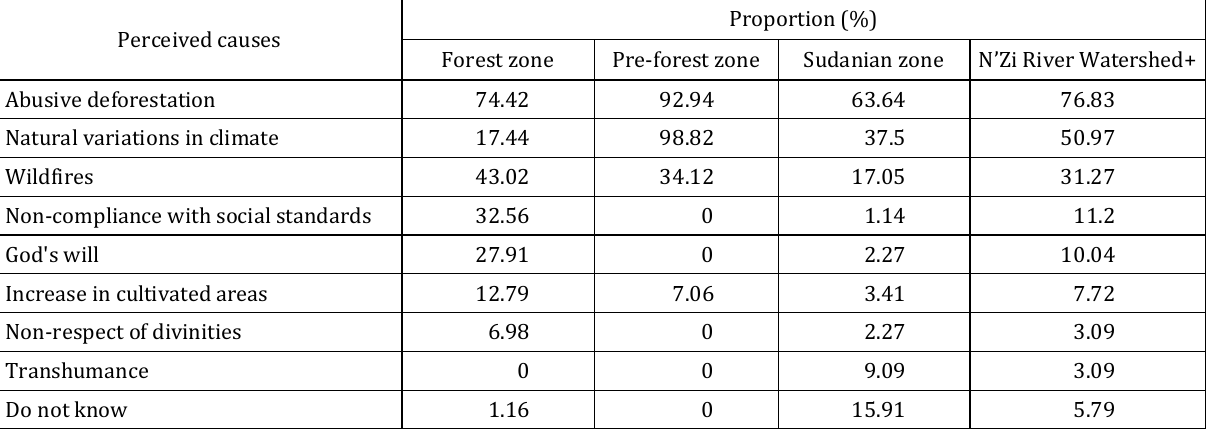
Table 4. Perceptions of farmers about the causes of climate change in the study area Perceived causes Forest zone